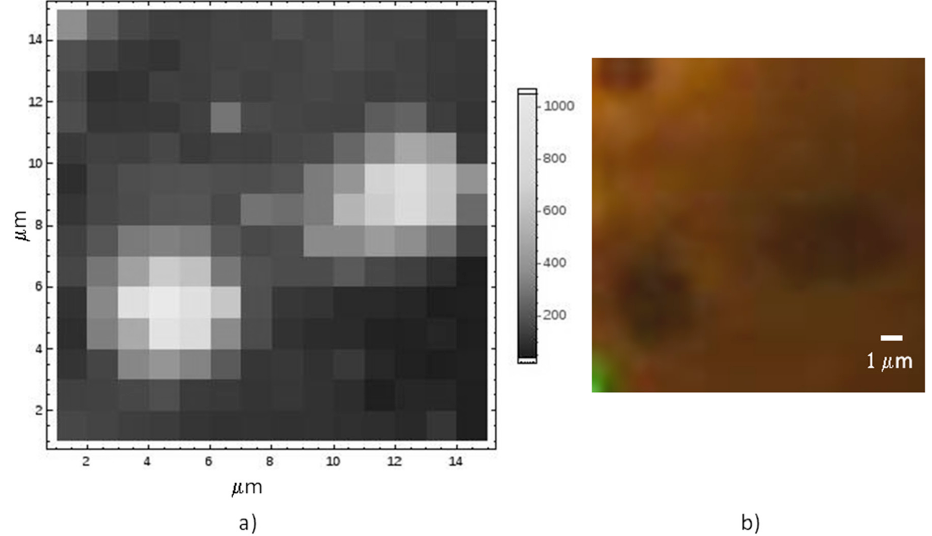
Figure 3. Raman analysis of graphene grown as suspended on metal holes: ( a ) the intensity of the Raman emission of graphene at ~2690 cm − 1 , the so-called 2D peak; and ( b ) the corresponding optical image displaying the three holes and the laser spot.